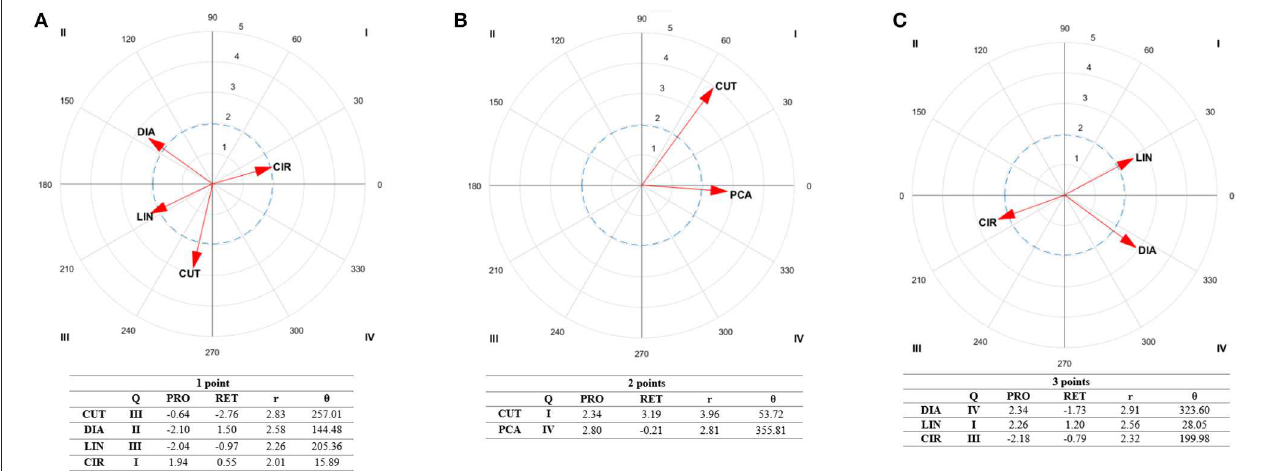
FIGURE 1 | Representation of behavioral maps for 1-point (A) , 2-point (B) , and 3-point (C) effective actions as focal behavior. The behavioral map was represented divided into four quadrants, with each of the conditioned categories as vectors in the axis X/Y and their respective coordinates Z sum prospective (X) and Z sum retrospective (Y). Significate vectors (Radium > 1.96), Zsum values, prospective (pros.) and retrospective (retr.) perspective, quadrants (Q), radium length (r), and vector angle ( θ ) are represented. CUT, Cuts; DIA, Direct Attack; PCA, Posterior Counterattack; LIN, linear technique; CIR, Circular